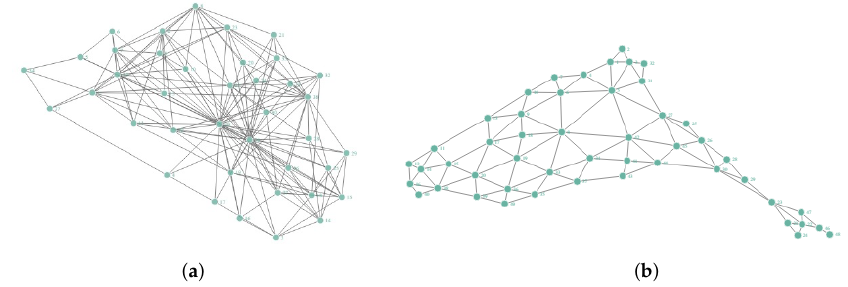
Figure 2. This figure shows the topological distribution of the real network in our network experiment. ( a ) Network topology of the Chesapeake Bay network. ( b ) Network topology of the contiguous USA